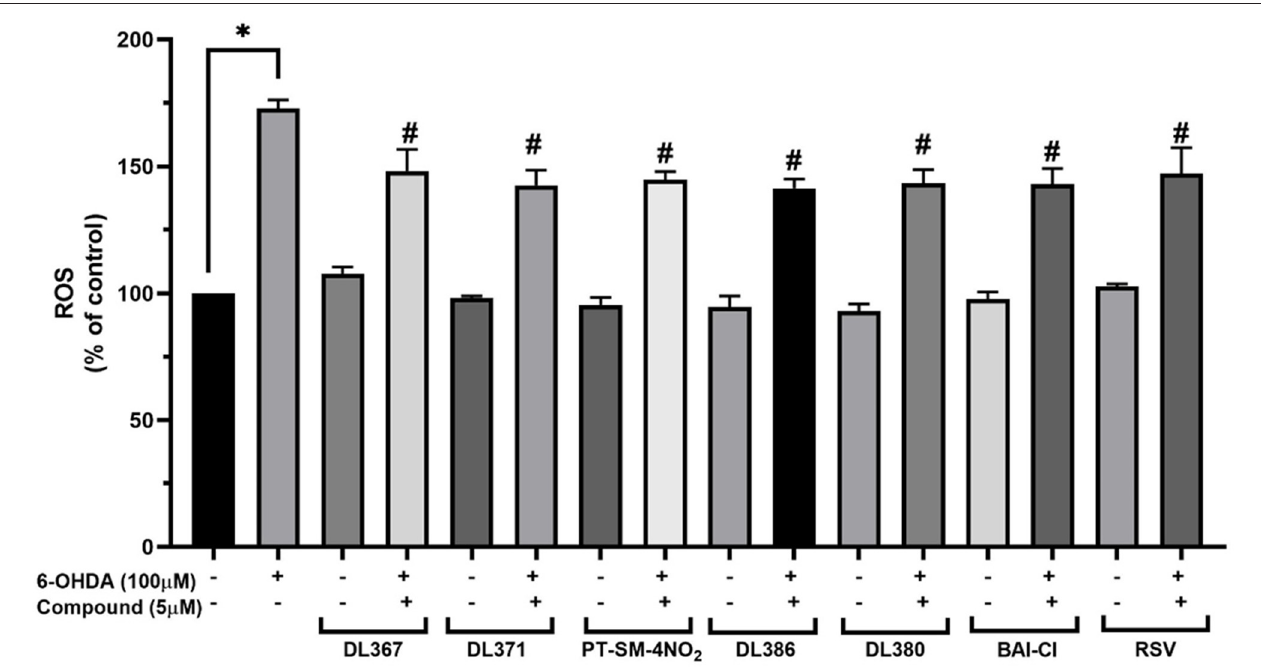
FIGURE 5 | Measurement of intracellular reactive oxygen species (ROS) levels in SH-SY5Y cells on 6-OHDA-induced ROS generation. The SH-SY5Y cells were incubated with 5 µ M of bis-sulfonamides or resveratrol for 3h followed by 100 µ M of 6-OHDA for 24h and determined by carboxy-DCFDA assay. The data are expressed as mean ± SEM, and statistical analysis was performed using one-way ANOVA. * P < 0.05 compared with the control cells; # P < 0.05 compared with the 6-OHDA.